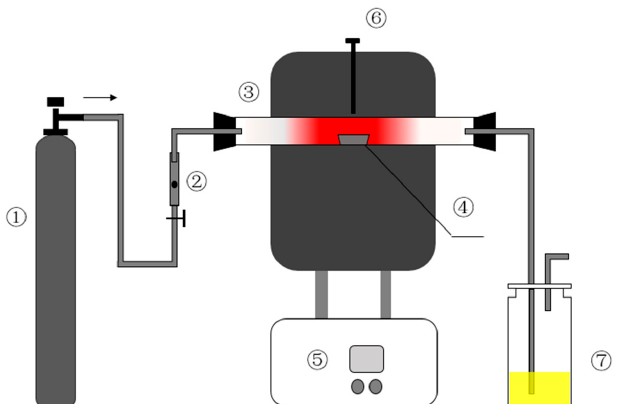
Figure 2. Schematic diagram of the pyrolysis reduction device ( ① —nitrogen bottle; ② —gas flow meter; ③ —quartz tube; ④ —sample; ⑤ —temperature control system; ⑥ —thermocouple; ⑦ —tail gas treatment).